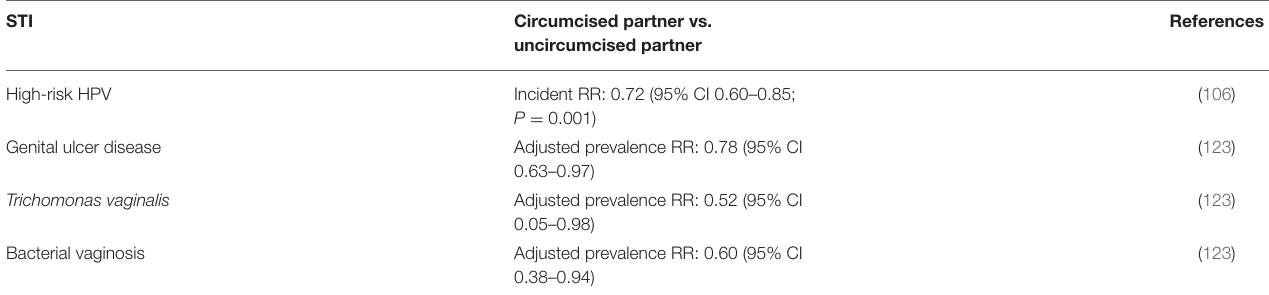
TABLE 2 | RCT findings for STIs that MC protects women against. STI Circumcised partner vs.